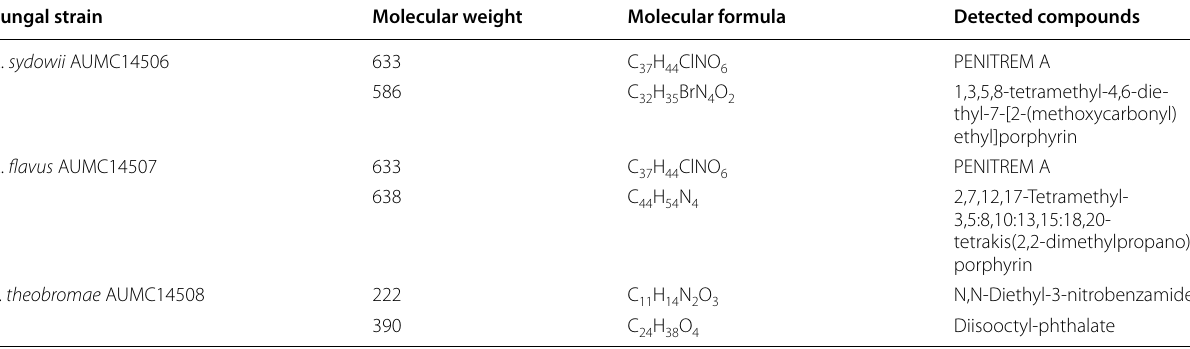
Table 5 GC‑MS analysis of the active fractions separated from TLC chromatography Fungal